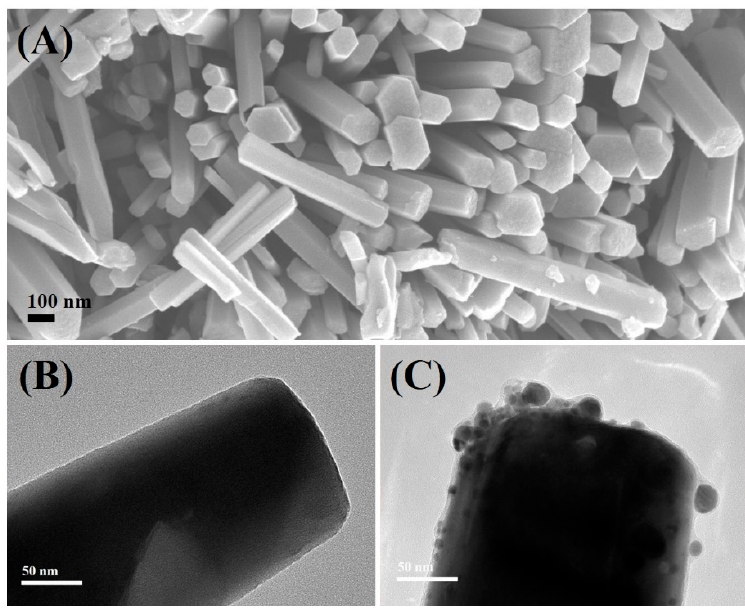
Figure 1. SEM ( A ) and TEM ( B ) images of as-prepared ZnO NRs. TEM image ( C ) of ZnO-Ag NRs (scale bar 50 nm). (scale bar 50